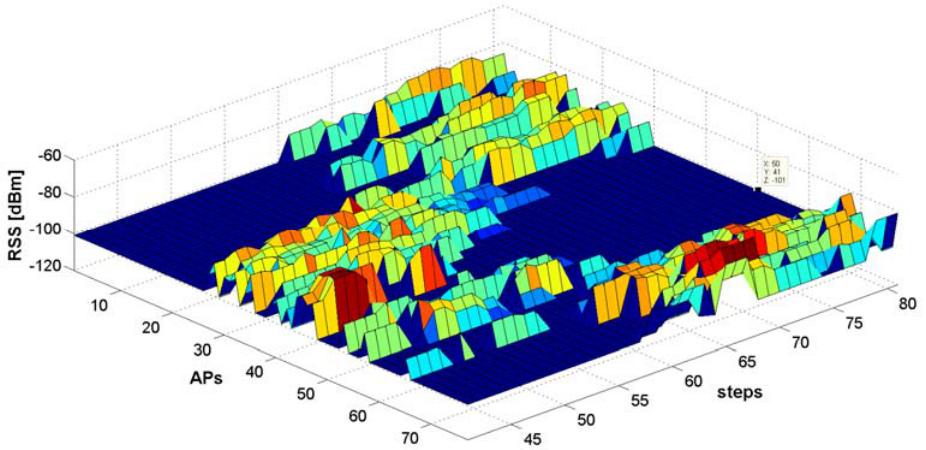
Figure 8. RSS values from the available APs in TL-EI5 from step 40 to